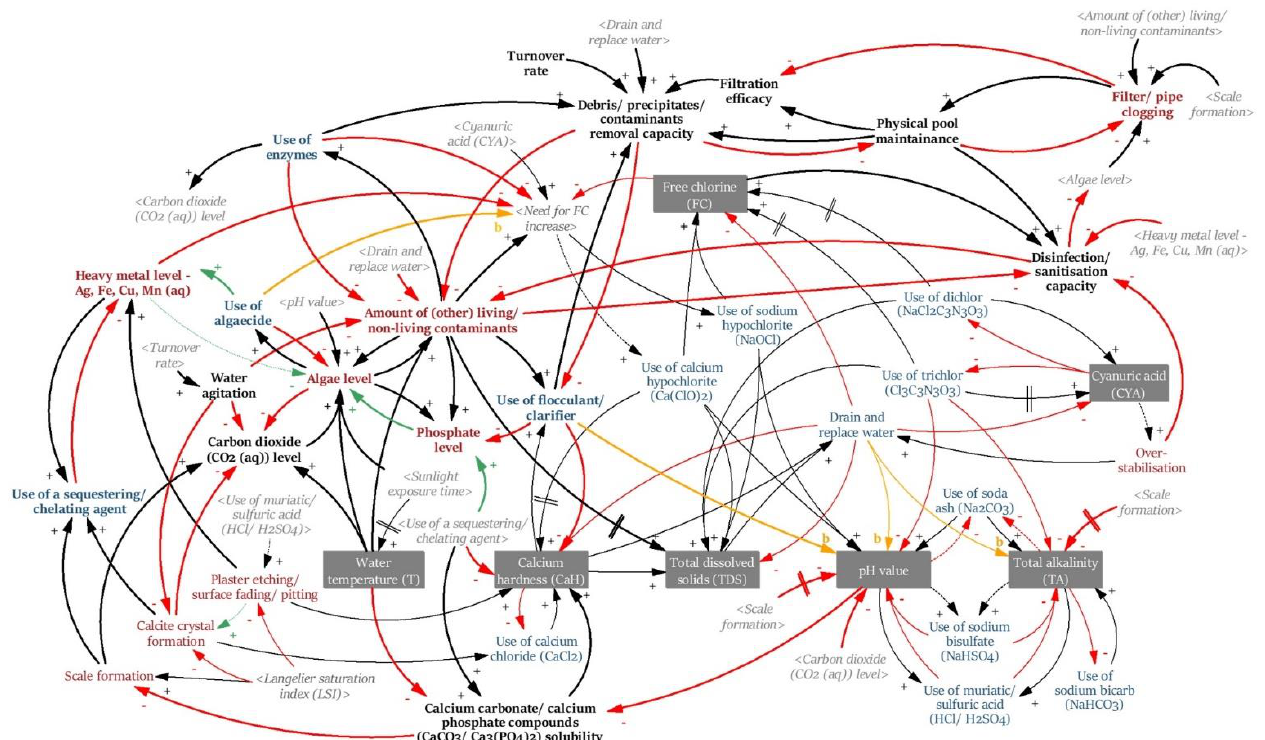
Figure 5. CLD 2: Supplementary swimming pool chemistry. Colour code is the same as in Figure 4 caption, additionally: green arrows represent a situation where either there is a relationship (+ or −) between two variables or no relationship at all, depending on the chemical composition of the affecting variable.